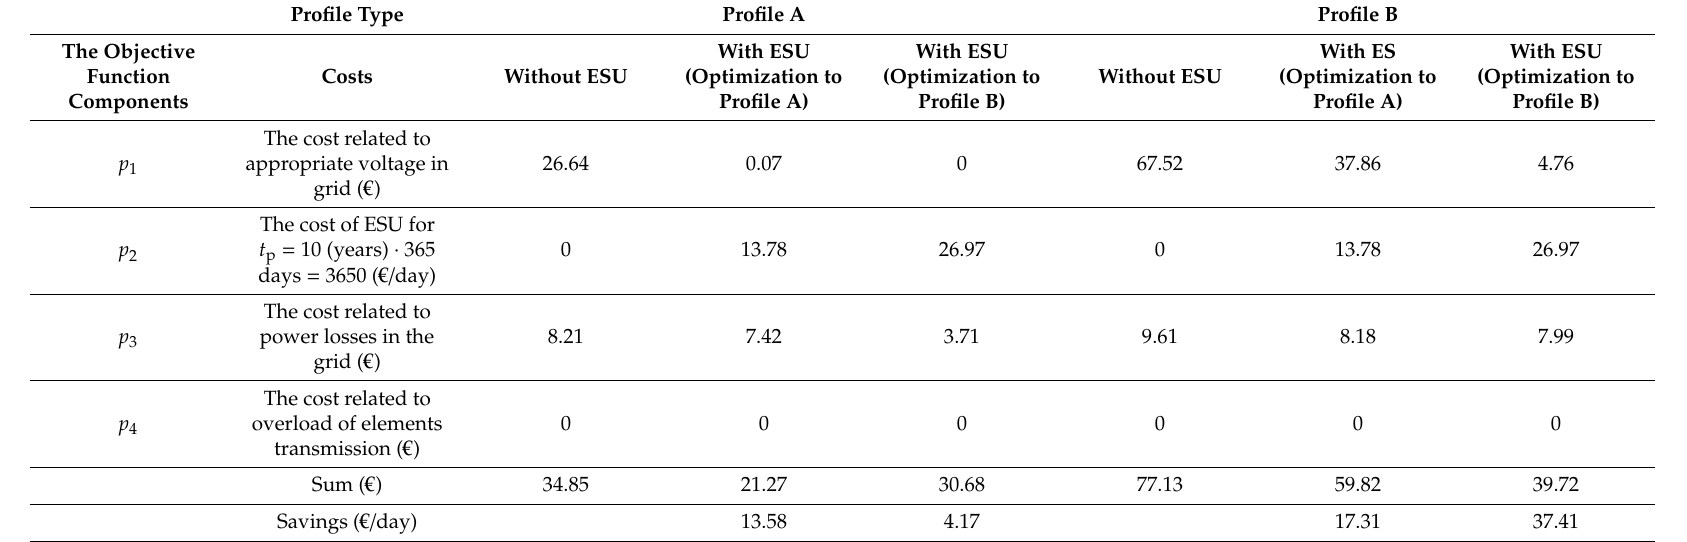
Table 6. Daily cost of grid operation: ‘without ESU’ and ‘with ESU’ for profiles A and